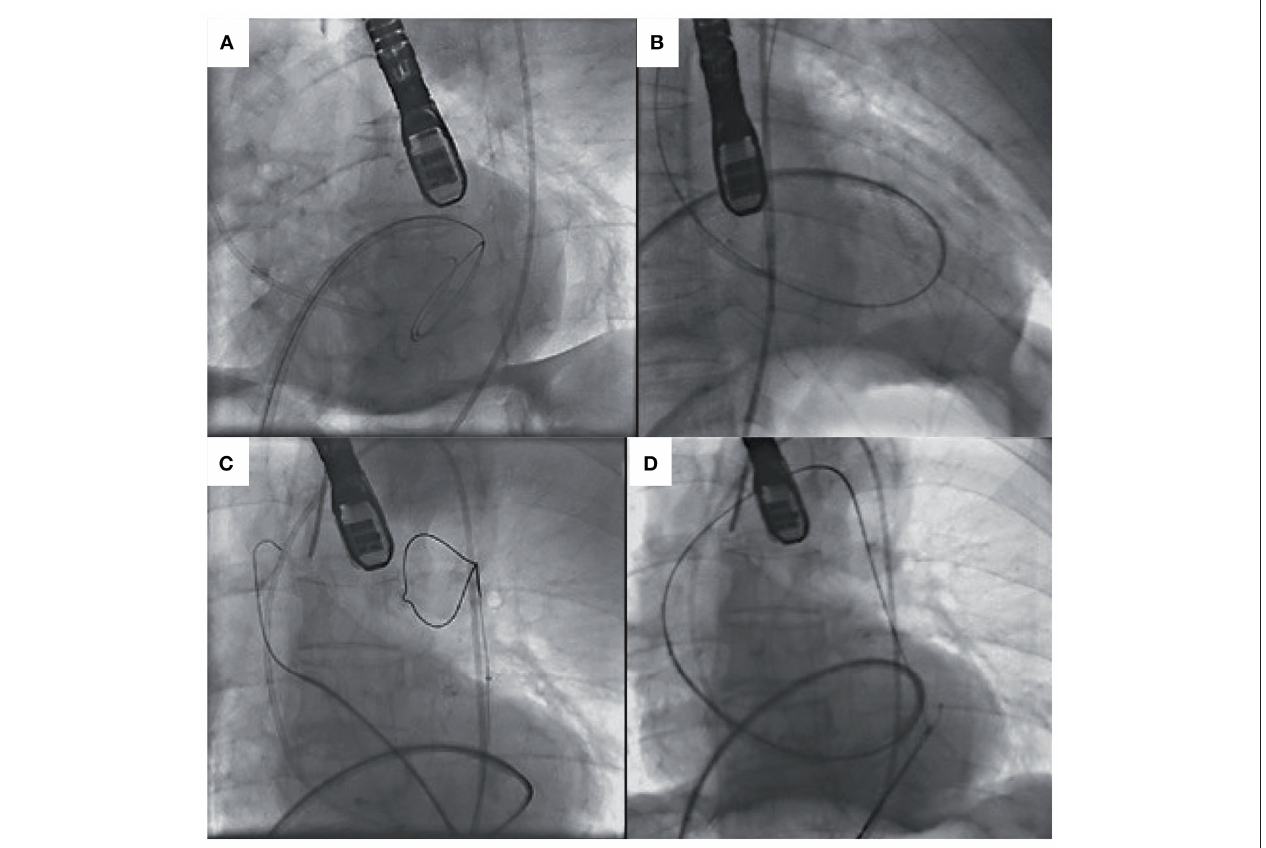
FIGURE 4 | (A) Transeptal puncture and positioning of hydrophilic wire and Judkins Right in the left ventricle. (B) Anterograde crossing of the aortic valve and wire changed for exchange wire. (C) Amplatz Goose Neck Snare used to snare the exchange wire. (D) Exchange wire then externalized via the left femoral artery [Adapted with permission from the Rodríguez-Olivares et al. (75)].